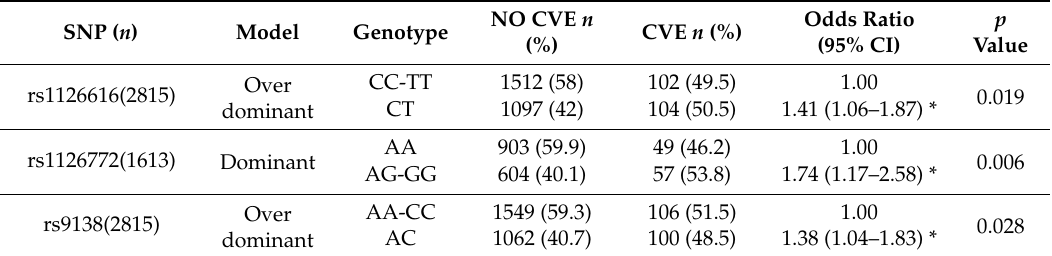
Table 2. Selected models of inheritance for the three SPP1 polymorphisms associated with the presence of cardiovascular events.